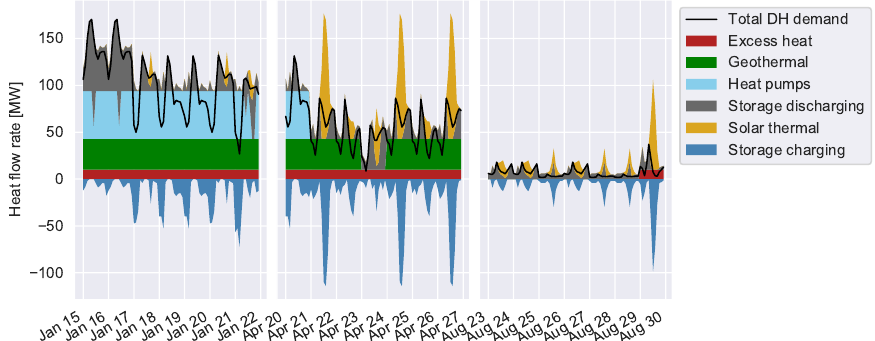
Figure 12. Detailed heating power plot of the intermediate PEIS design for a winter, spring and summer